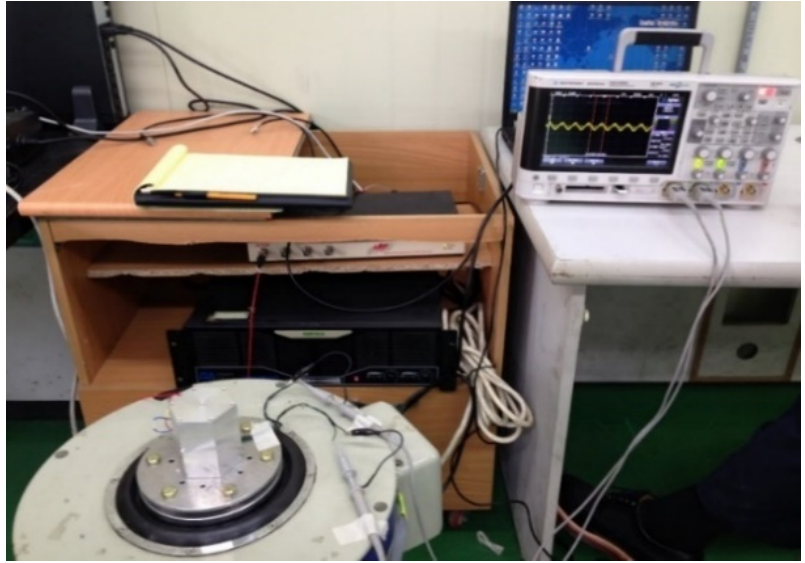
Figure 10. Performance test and measurement system for the magnetic spring vibration-energy-harvesting device in the laboratory.